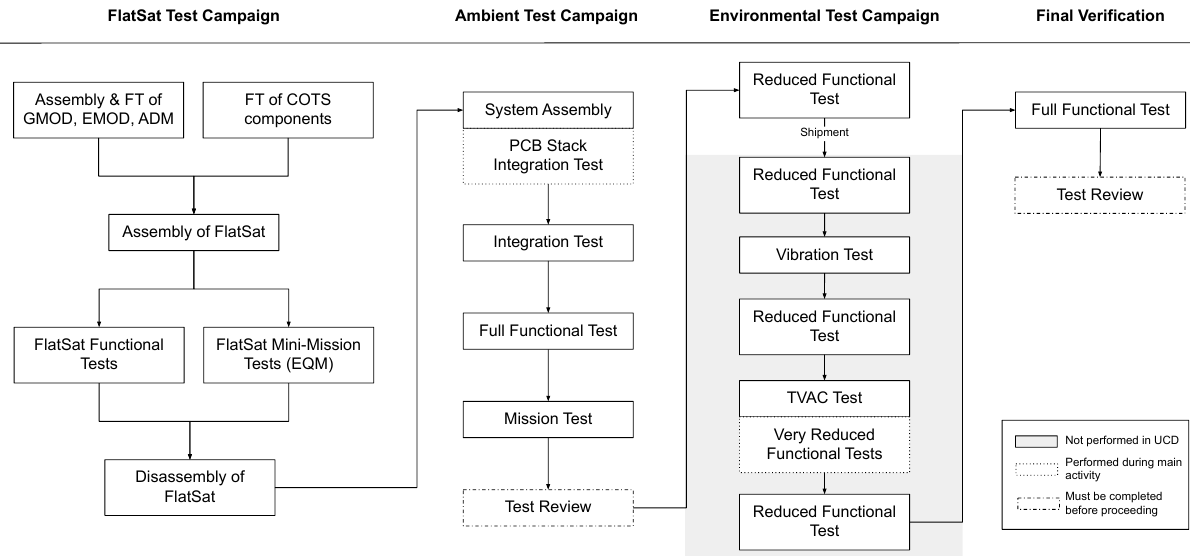
Figure 3. Test campaigns of EIRSAT-1 highlighting the assembly, integration, verification, and test activities to be performed. FlatSat ‘mini-mission’ tests are performed on the EQM only. As the environmental test campaign does not take place at UCD a reduced functional test must be performed before and after shipment of the